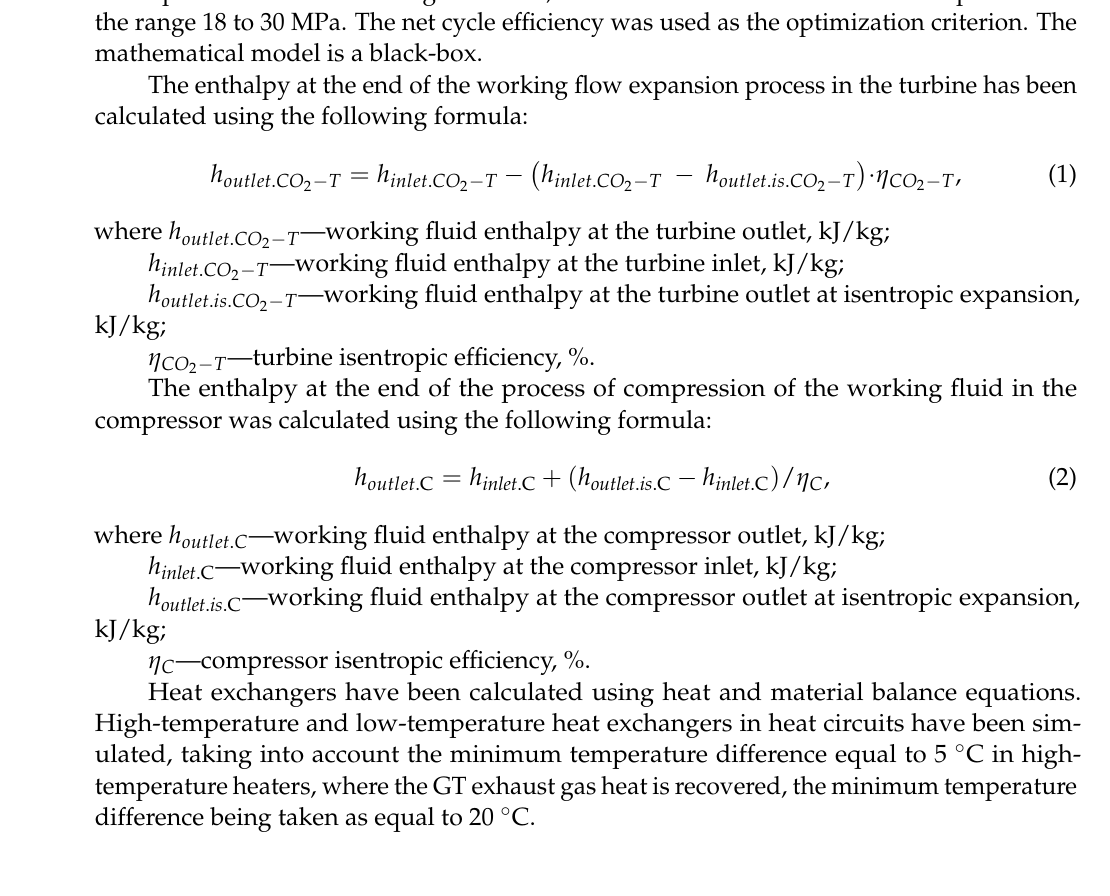
2 Brayton cycle in Aspen